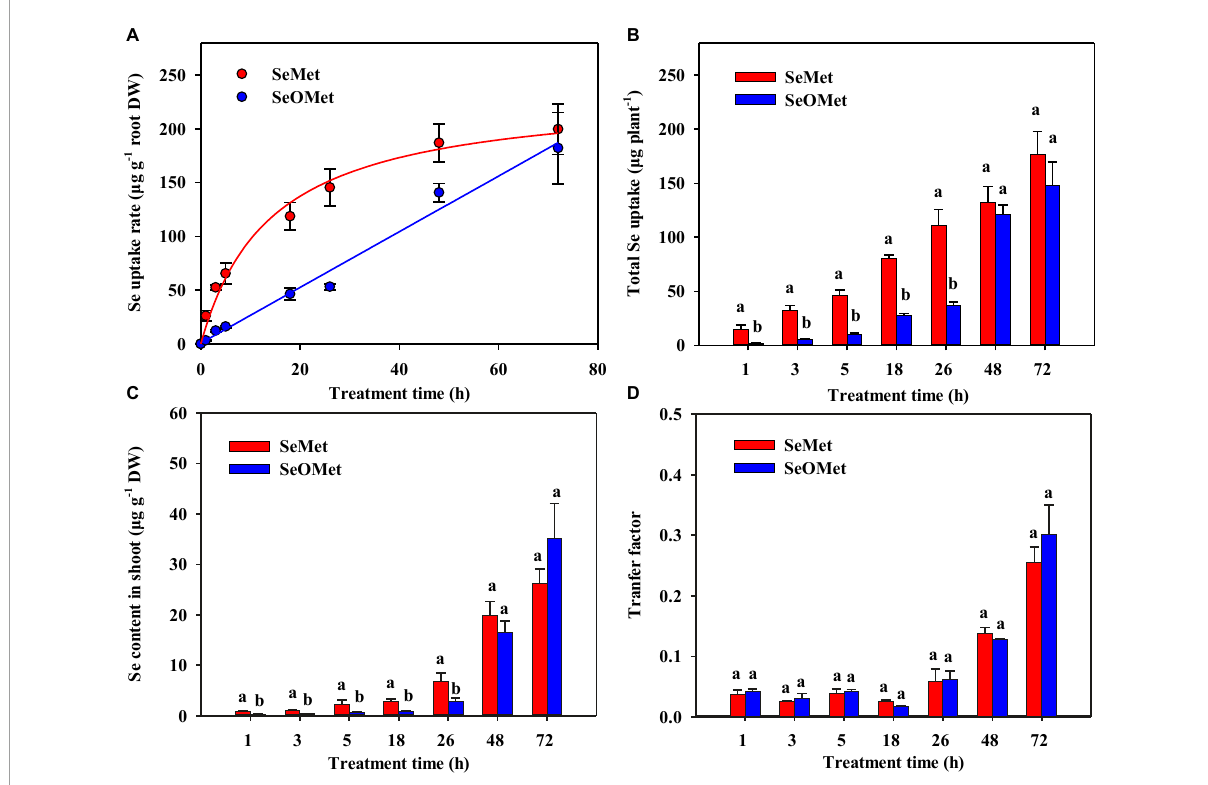
FIGURE2 Time-dependent kinetics of the uptake of organic Se by rice roots (A) , total Se uptake (B) , the contents of Se in rice shoots (C) , and the transfer factor of Se from roots to shoots (D) . Data are presented as mean ± SE ( n = 4). Different lowercase letters above bars indicate significant differences between SeMet and SeOMet treatments in individual treatment times ( P < 0.05).